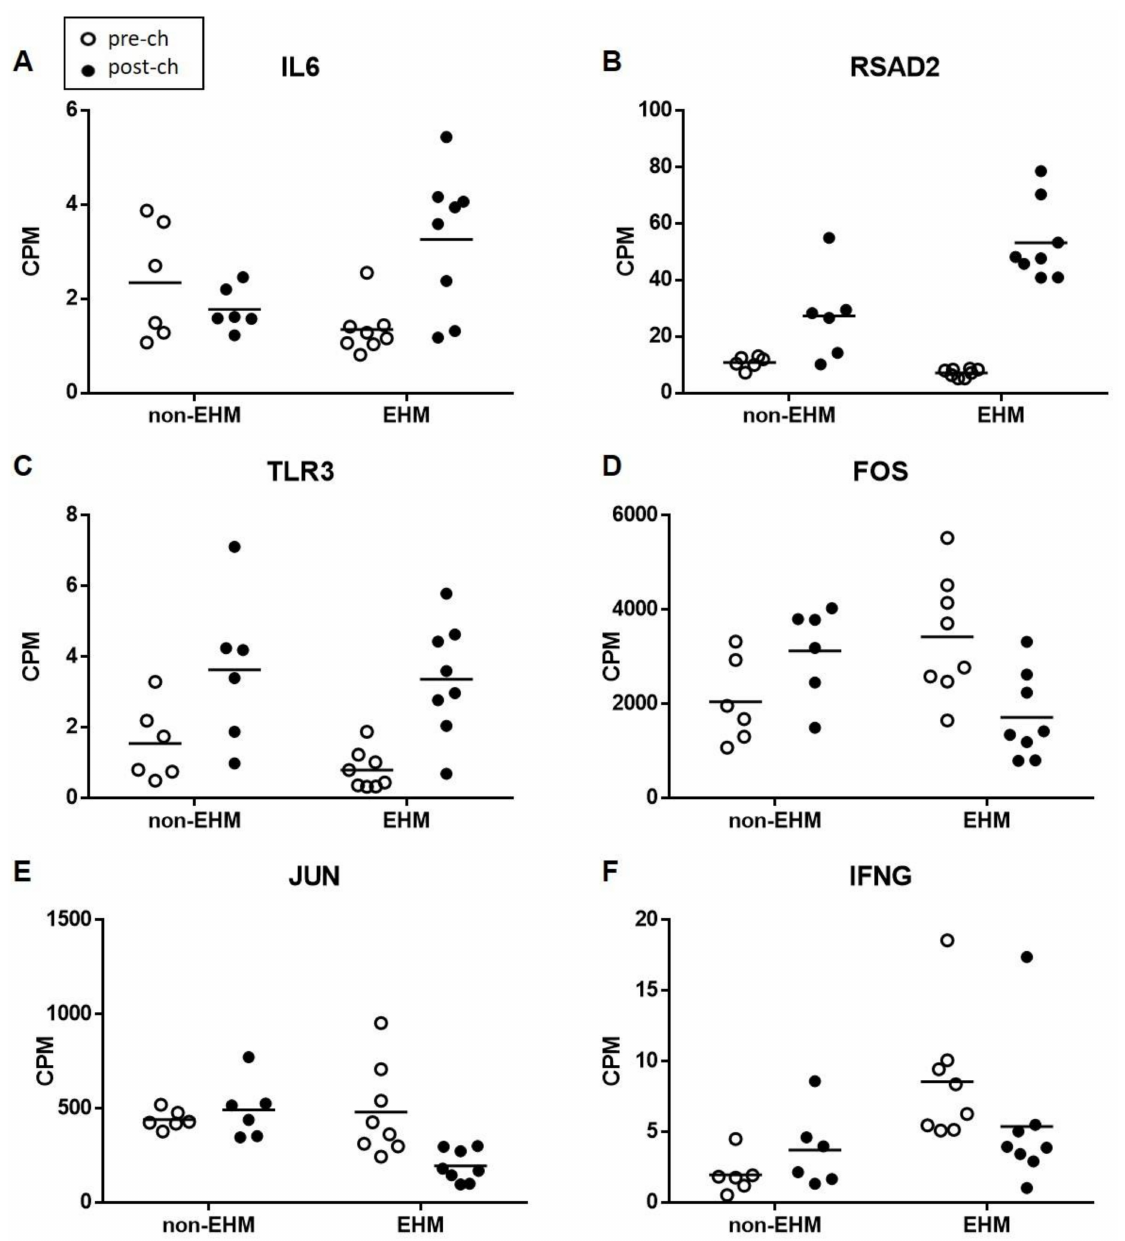
Figure 9. Normalized read counts (cpm) of selected genes in PBMCs of horses. ( A ) IL6 ( B ) RSAD2 ( C ) TLR3 ( D ) FOS ( E ) JUN ( F ) IFNG. All differences in responses are statistically significant at p <